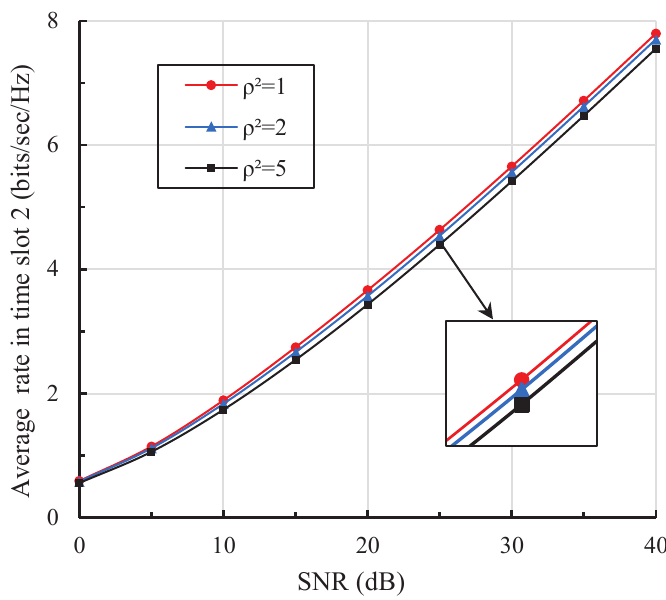
Figure 4. The average rate of TPIA in sub-time slot 2 under different amplification